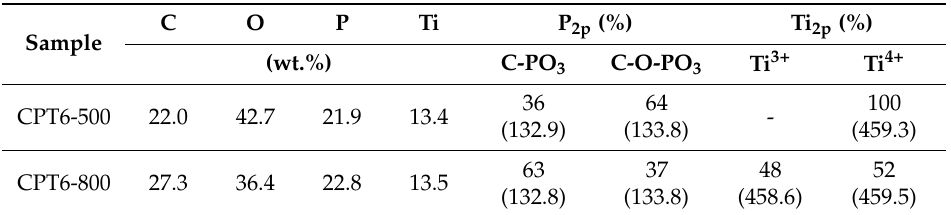
Table 1. Surface concentration, species percentage and corresponding binding energies (in brackets, eV) obtained for the CTP6 sample obtained at different carbonization